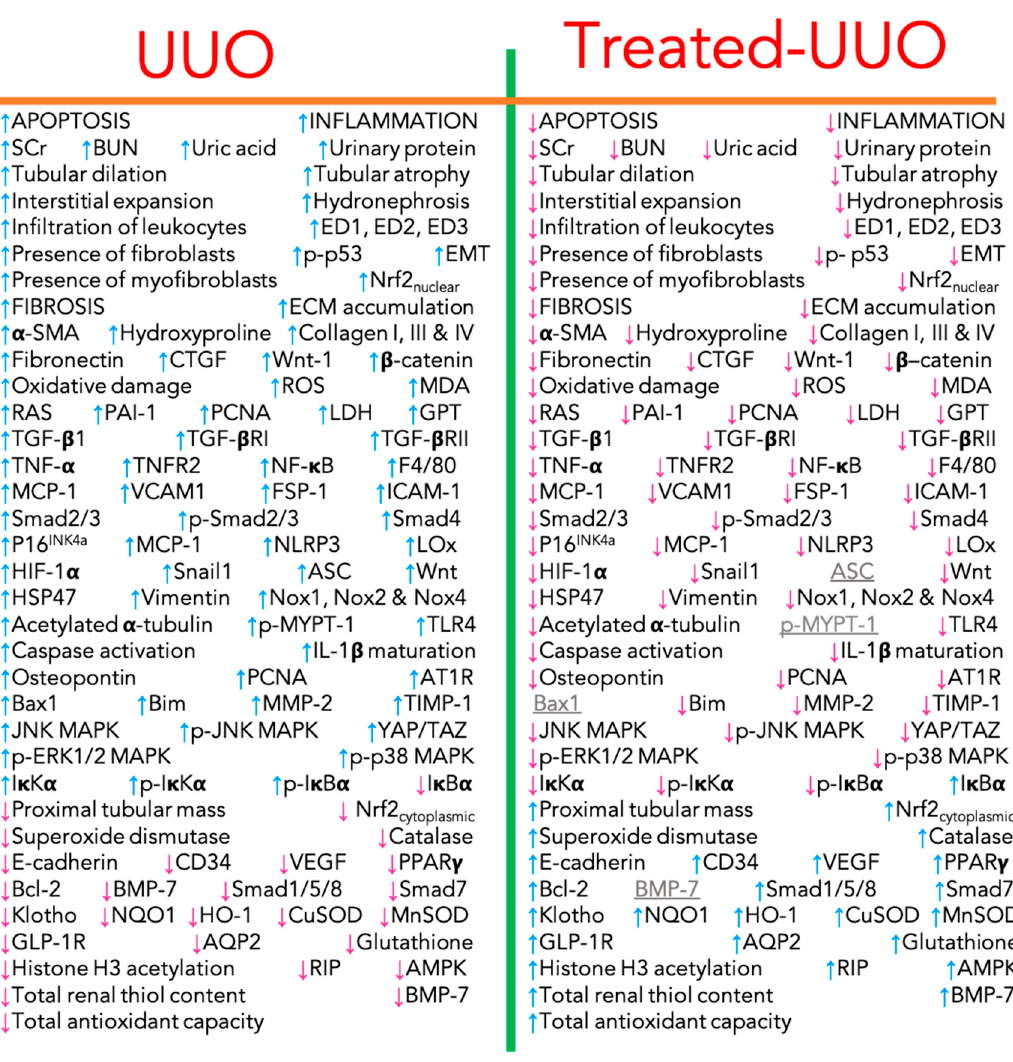
Figure 7. Encompassing summary of the histological lesions, protein levels or protein activities in untreated UUO and treated-UUO. The “UUO” section is the comparison between the untreated-UUO groups and the Sham-groups, whereas the “Treated-UUO” section is a comparison between the untreated-UUO groups and the treated UUO-groups. Up-arrows indicate increase, down-arrows indicate decrease and gray-underline indicates unchanged levels.